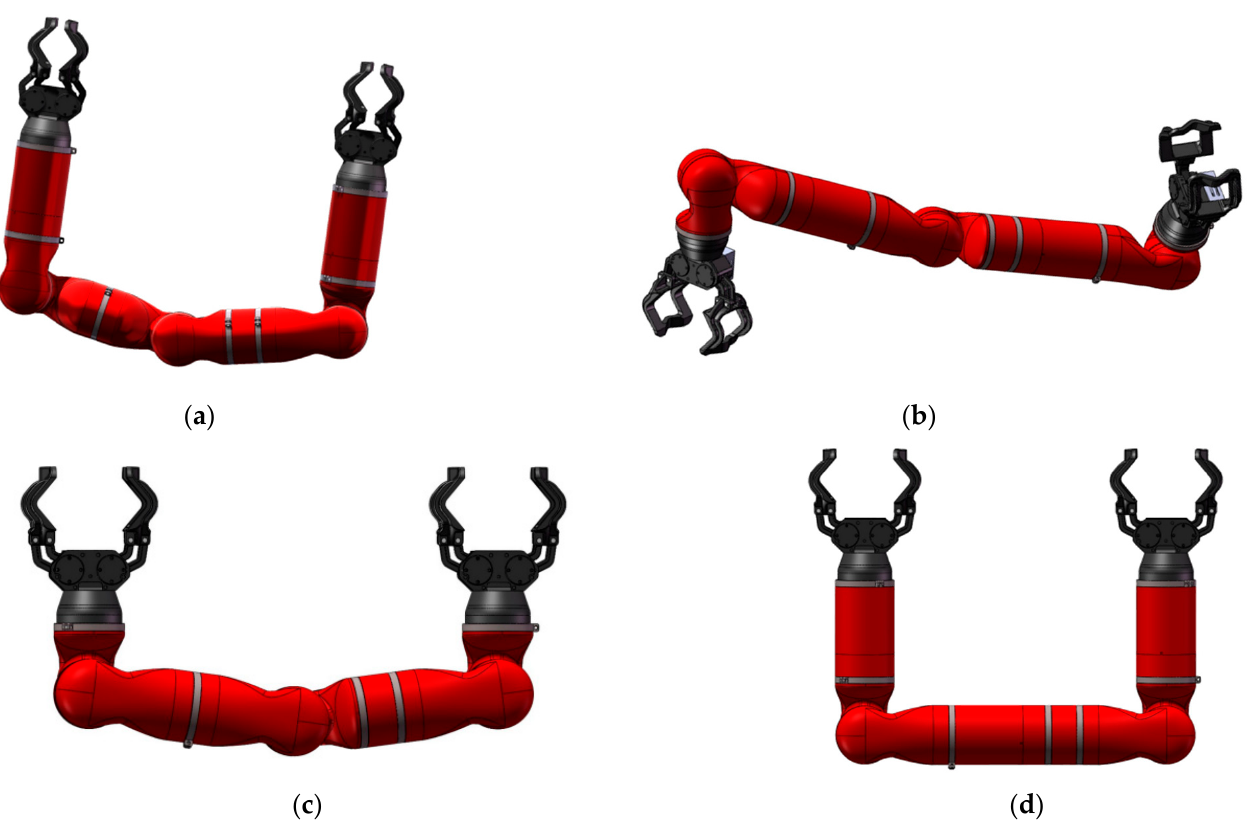
Figure 4. Different configurations robots made up of different modules. ( a ) 6-1 ⊥ 7//7//7 ⊥ 1-6, ( b ) 6-7//1 ⊥ 7 ⊥ 1//7-6, ( c ) 6-7//7//7-6, ( d ) 6-1 ⊥ 7//1//7 ⊥ 1-6.